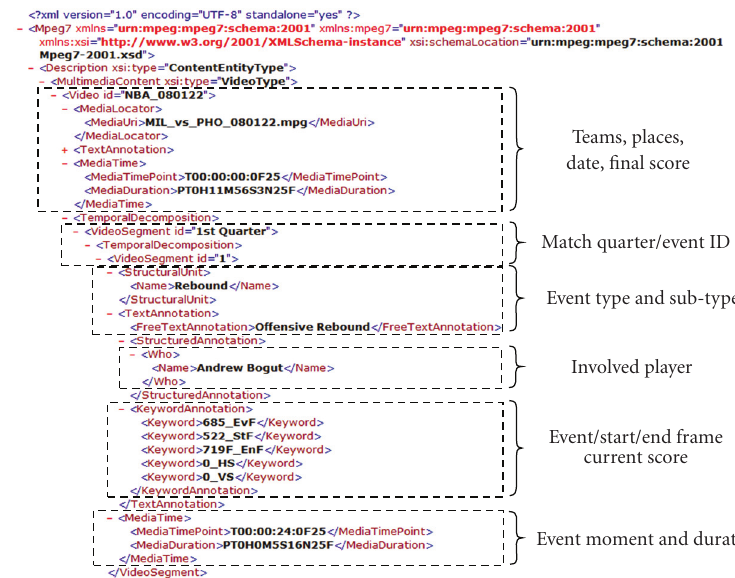
Figure 7: An example of MPEG-7 sports video description XML file.